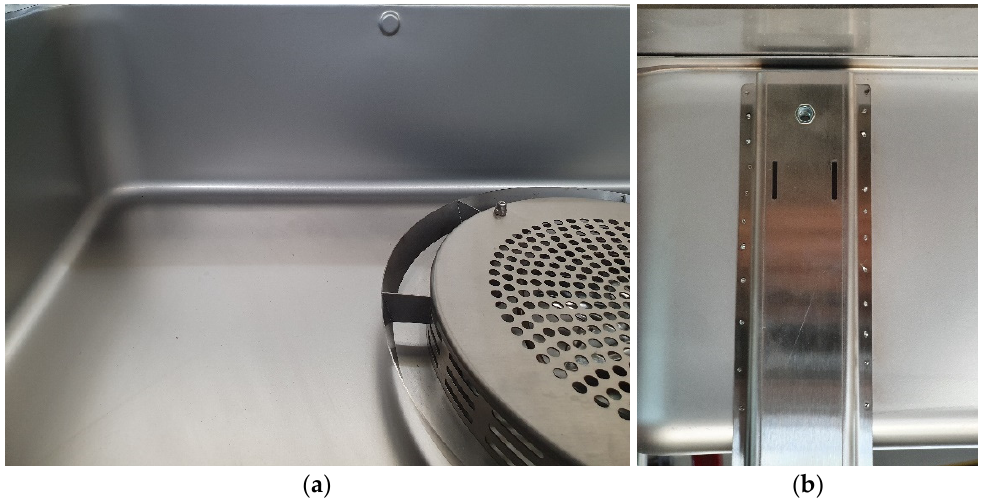
Figure 2. Visual micro ‐ laser spot welding application on thin inox material. ( a ) Visible surface (0.8 mm thick 304 stainless steel sheet on “Cold well with fan”). It is expected that there will be no heat trace or deformation due to welding on this inox surface of the device. ( b ) Invisible surface (2 mm thick 304 stainless steel sheet “well support, hook sheet”). Laser marks on this surface, located on the hidden interior of the device, are an acceptable error. Table 1. Material properties of test sample stainless steel sheets. (Guangdong Yongjin Metal Tech ‐